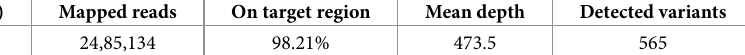
Table 2. The average data output in deep sequencing. Number of